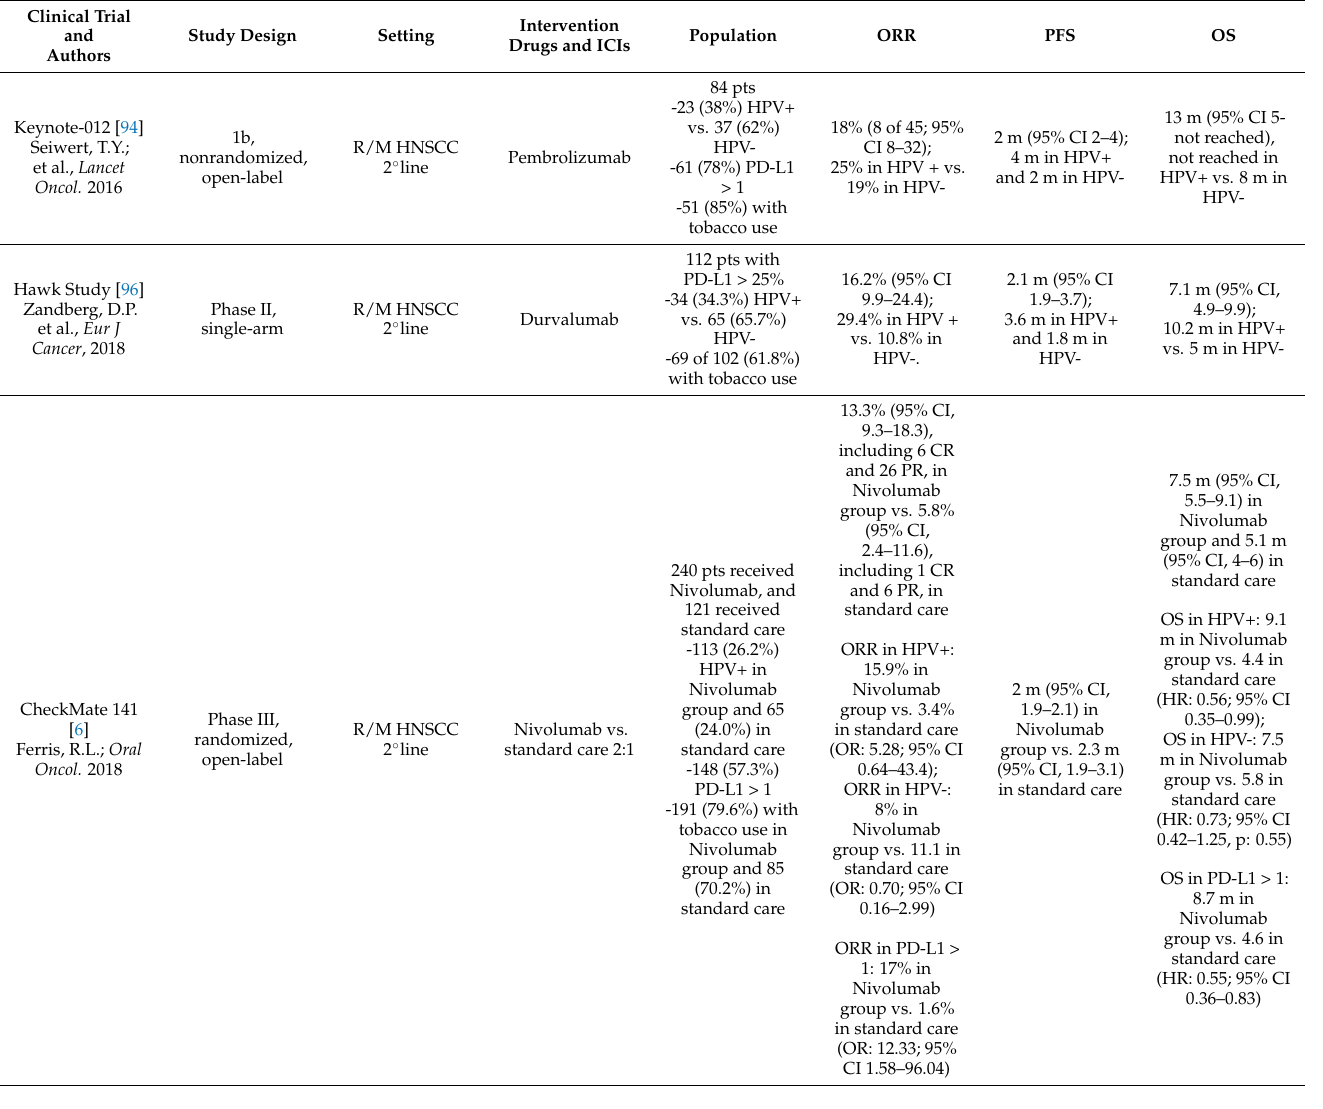
Table 2. Clinical trials using ICIs in